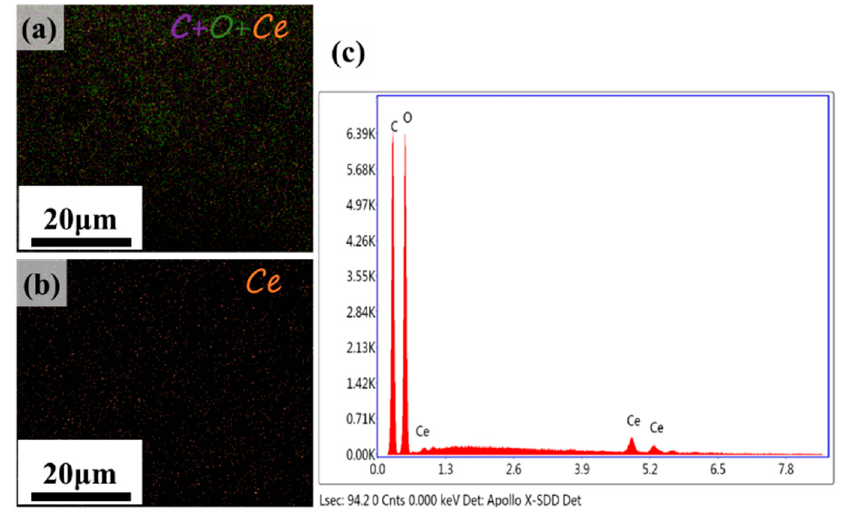
Figure 5. ( a ) C + O + Ce; ( b ) Ce EDS mapping images and ( c ) EDS analysis of the surface of the RC-0.2 film.